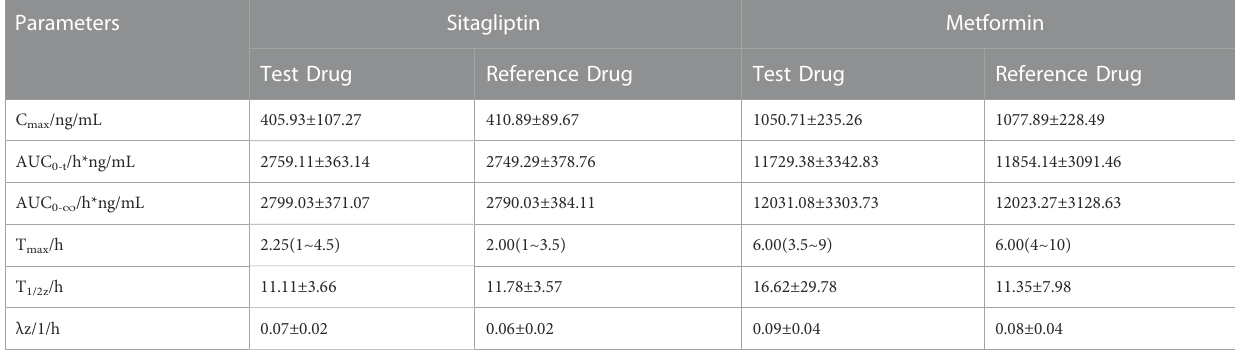
TABLE 4 Pharmacokinetic parameters after single-dose administration of test and reference drug under fed state.